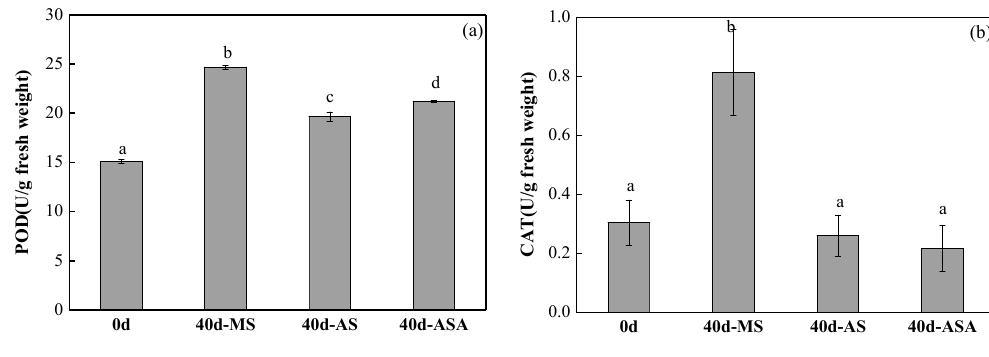
Figure 6. Enzyme activity of V. natans in MS, AS and ASA groups.